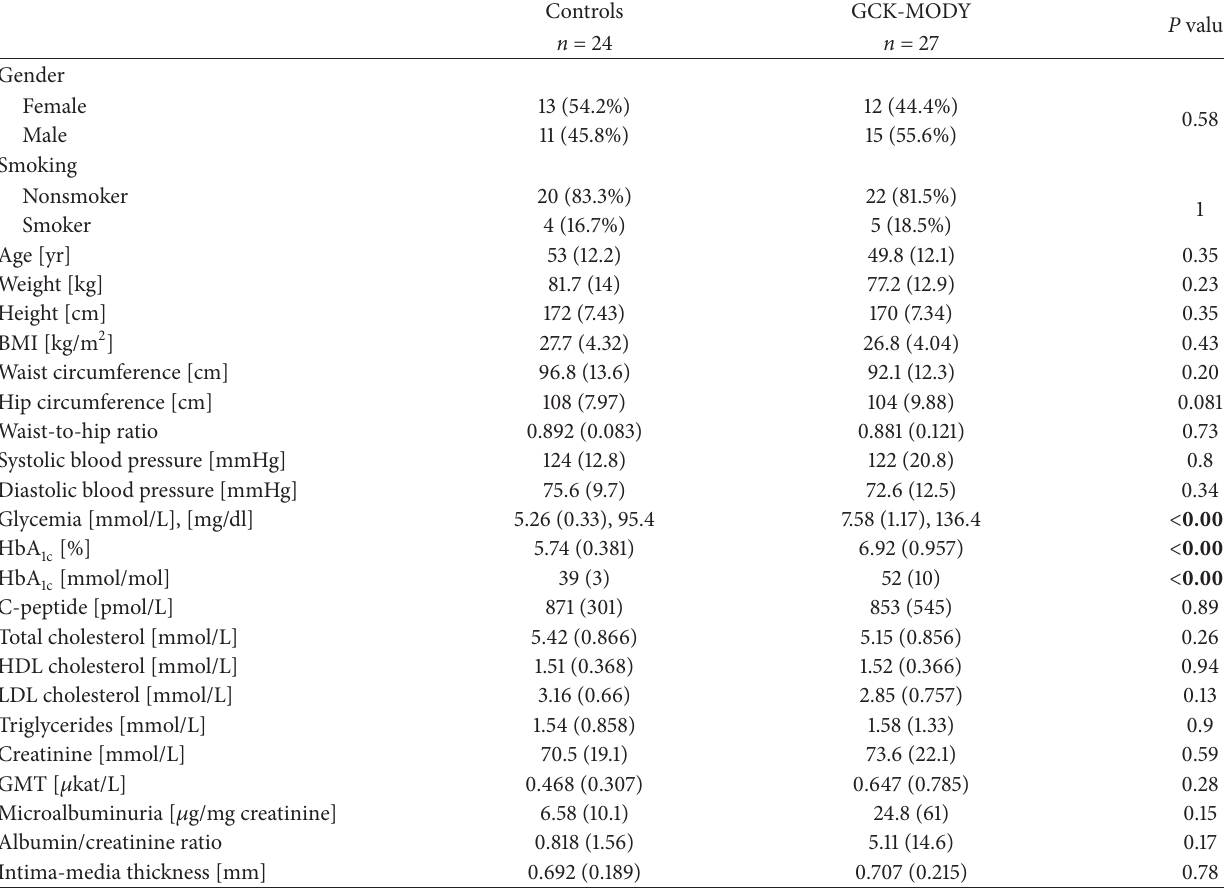
Table 1: Clinical and biochemical characteristics of participants with GCK-MODY and control